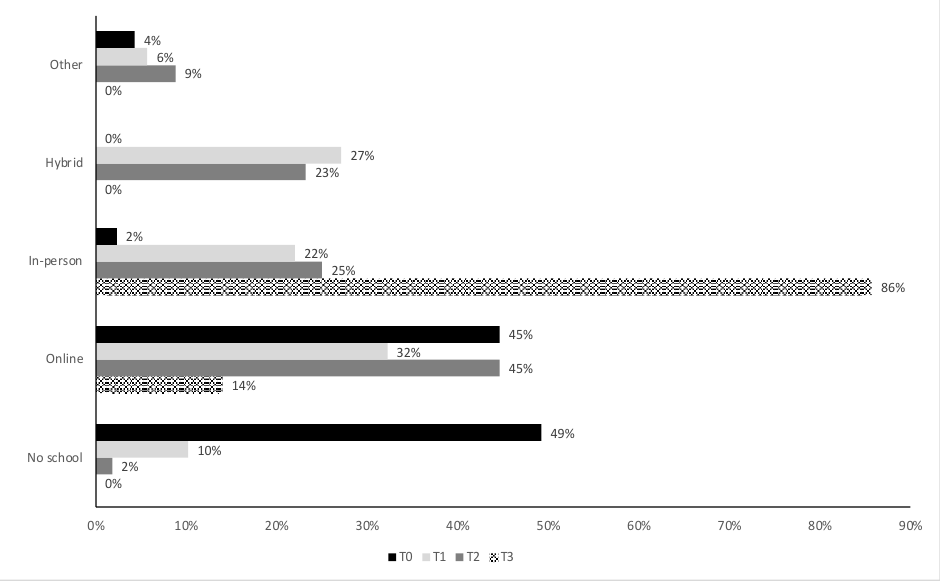
Figure 1. School format for participants by survey timepoint. “Other” comprises those reporting home-schooling and schooling by mailed packets.